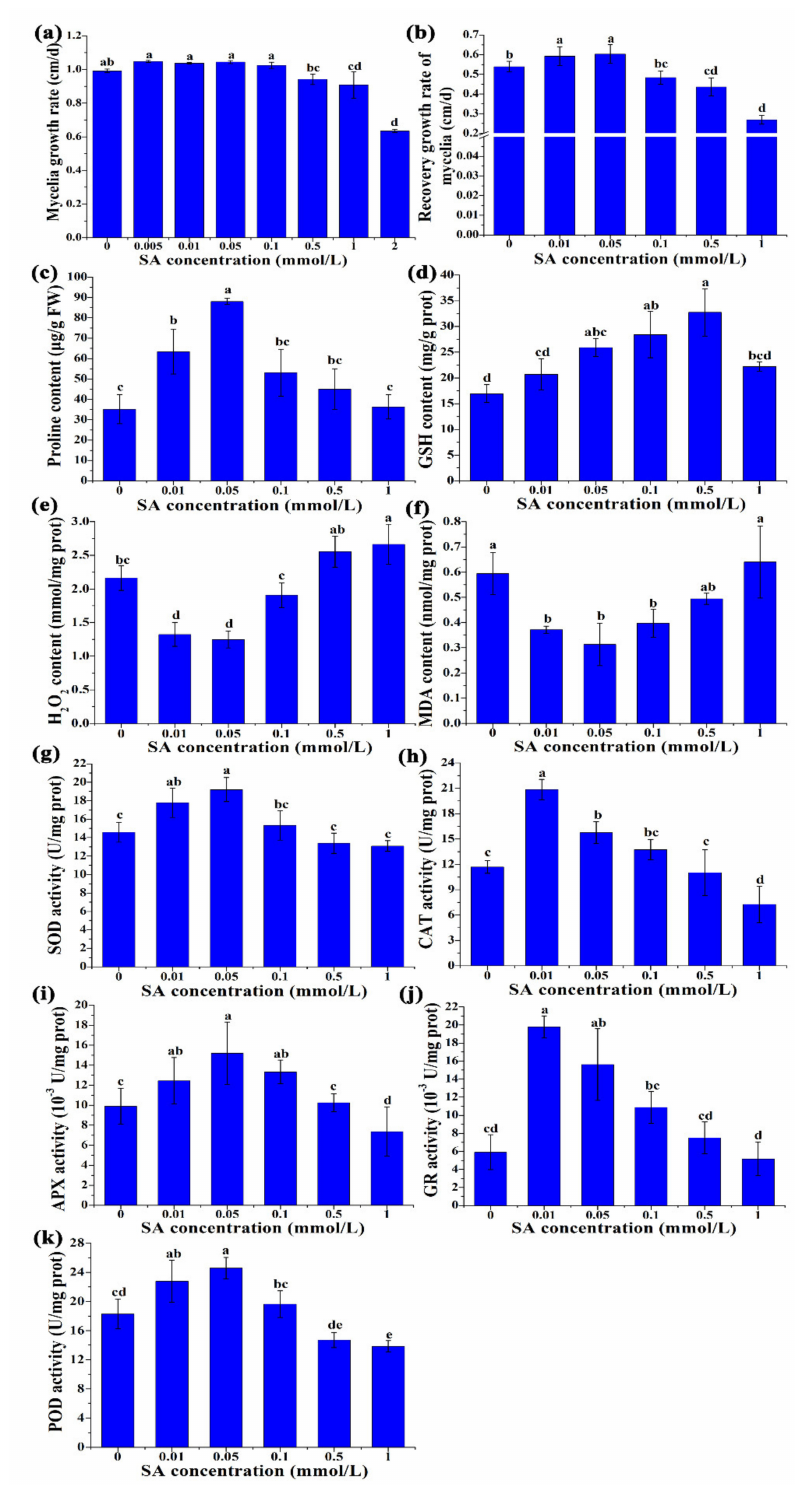
Figure 1. Physiological and biochemical changes with different concentrations of SA treatment under heat stress. ( a ) Mycelia growth rate; ( b ) recovery growth rate of mycelia; ( c ) proline content; ( d ) GSH content; ( e ) H 2 O 2 content. ( f ) MDA content; ( g ) the activities of SOD; ( h ) the activities of CAT; ( i ) the activities of APX; ( j ) the activities of GR; ( k ) the activities of POD. The results are expressed as the means ± SD ( n = 3). Different letters indicate significant differences between strains ( p < 0.05, Tukey’s